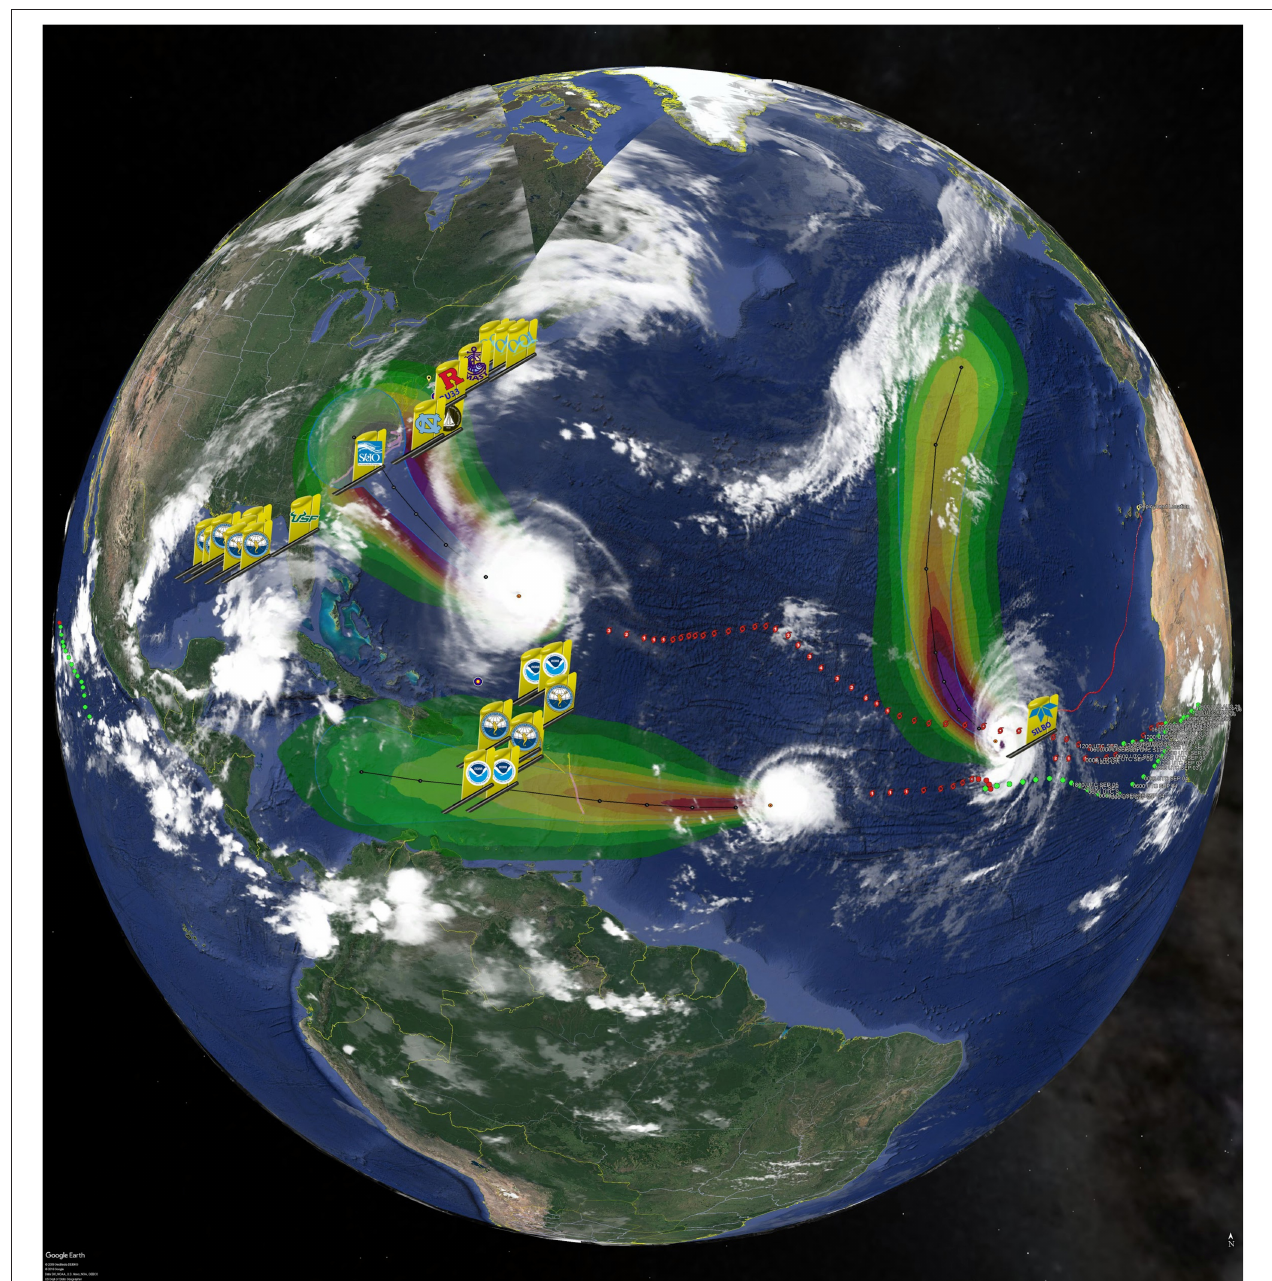
FIGURE 8 | Hurricane Florence, Isaac and Helene cloudtops (left to right) on September 11, 2018, with NHC best tracks behind each hurricane, NHC probability of tropical storm force winds ahead of each hurricane, and the tails of the diverse fleet of ocean glider in the picket lines transmitting upper ocean data in near-real time to